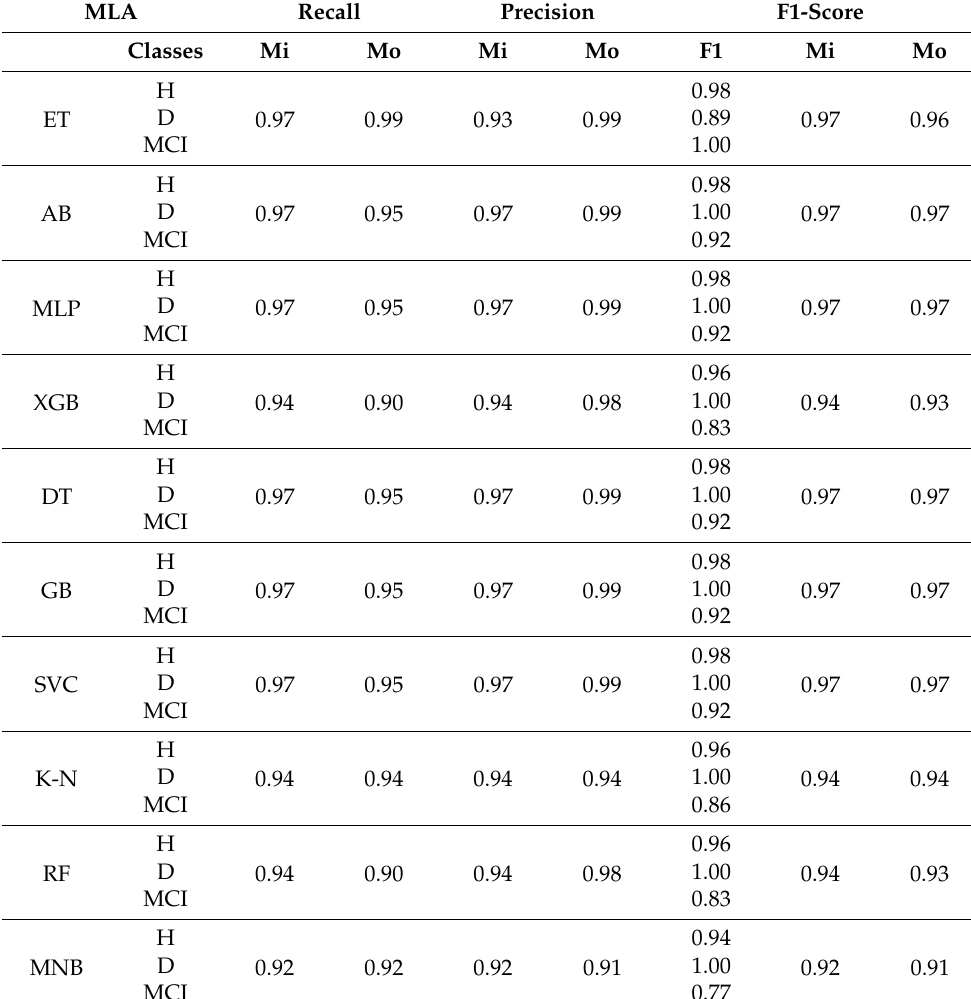
Table 4. Micro-avg and macro-avg metrics to determine the performance of the machine learning models. MLA Recall Precision F1-Score Classes Mi Mo Mi Mo F1